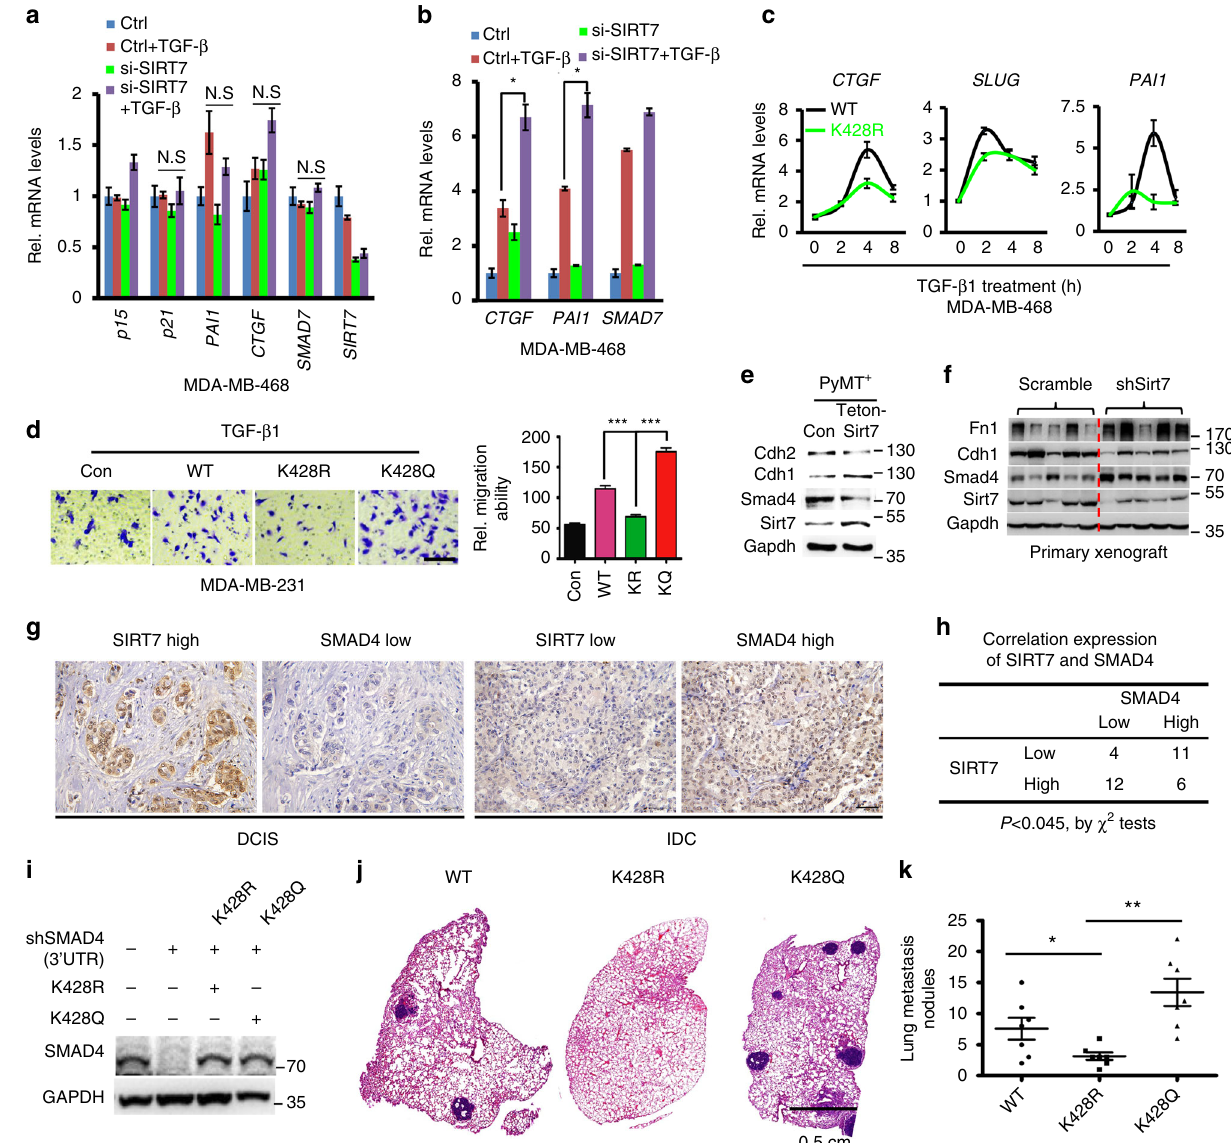
Fig. 7 SMAD4 underlies SIRT7-mediated TGF- β signaling. a Real-time RT-PCR analysis of TGF- β downstream genes in SMAD4 -de fi cient MDA-MB-468 cells treated with control or SIRT7 siRNA in the presence or absence of TGF- β 1 (5 ng/ml, 4 h). b Real-time RT-PCR analysis of TGF- β downstream genes in SMAD4 -restored MDA-MB-468 cells treated with control or SIRT7 siRNA in the presence or absence of TGF- β 1 (5 ng/ml, 4 h). c Quantitative RT-PCR analysis of TGF- β signaling genes. MDA-MB-468 cells were reconstituted with WT or K428R SMAD4 and treated with TGF- β 1 (5 ng/ml) as indicated. d Transwell invasion assay of MDA-MB-231 cells ectopically expressing WT, K428R, or K428Q SMAD4 in the presence of TGF- β 1 (5 ng/ml). Endogenous SMAD4 was stably knocked down by shRNA-targeted 3 ’ UTR. Relative invasive ability was normalized to empty vector. e Immunoblots showing EMT markers, and negative correlation between Smad4 and Sirt7 levels in primary tumors obtained from PyMT; Sirt7 tg and control mice. f Immunoblots showing EMT markers, and negative correlation between Smad4 and Sirt7 levels in tumors from mice of mammary fat pad burden with control or Sirt7 KD 4T1 cells. g Representative images of a human breast cancer tissue array showing SIRT7 and SMAD4 protein levels in ductal carcinoma in situ (DCIS, SIRT7 high, and SMAD4 low) and invasive ductal carcinoma (IDC, SIRT7 low, and SMAD4 high). Scale bar , 50 µ m. h Overall correlated expression of SIRT7 and SMAD4 in a human breast cancer tissue array of g . i Representative immunoblots showing expression of SMAD4s. j H&E-stained lung section images showing metastatic nodules. k Scatter plot showing lung metastatic nodules in xenograft models ( n = 7 for each group). * P < 0.05, ** P < 0.01, *** P < 0.001. P- values are calculated by non-parametric Mann – Whitney U -test k , Student ’ s t -test a , b , d or χ 2 -test h . Data are shown as mean ± S.E.M. N.S., no signi fi